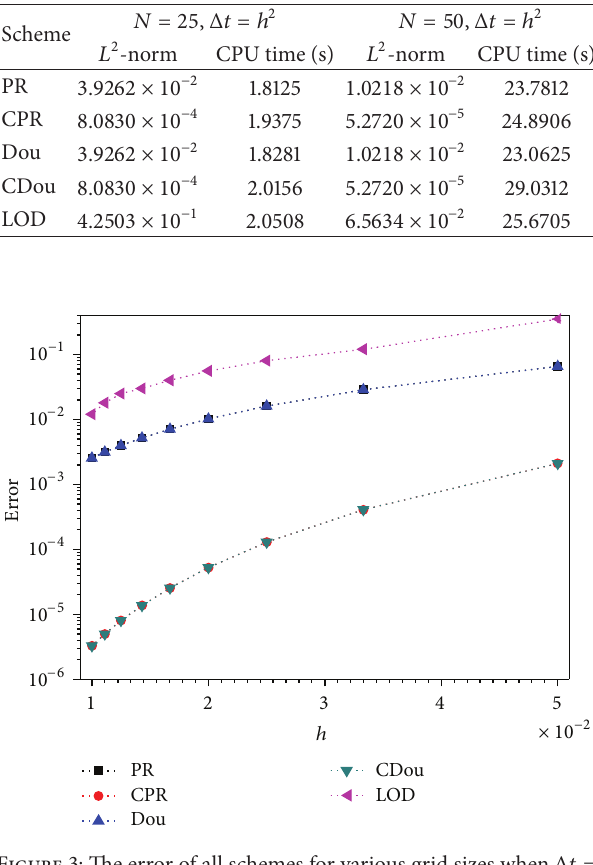
Figure 3: The error of all schemes for various grid sizes when Δ𝑡 = ℎ 2 .